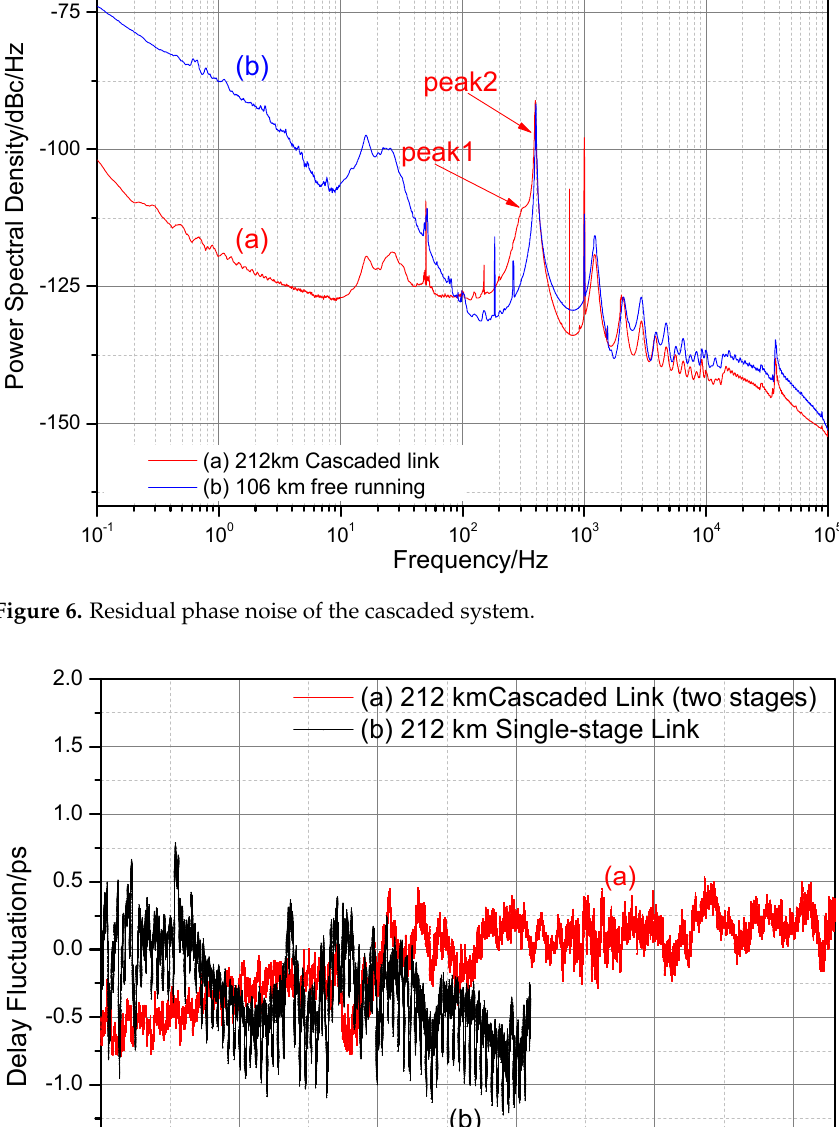
Figure 6. Residual phase noise of the cascaded system.